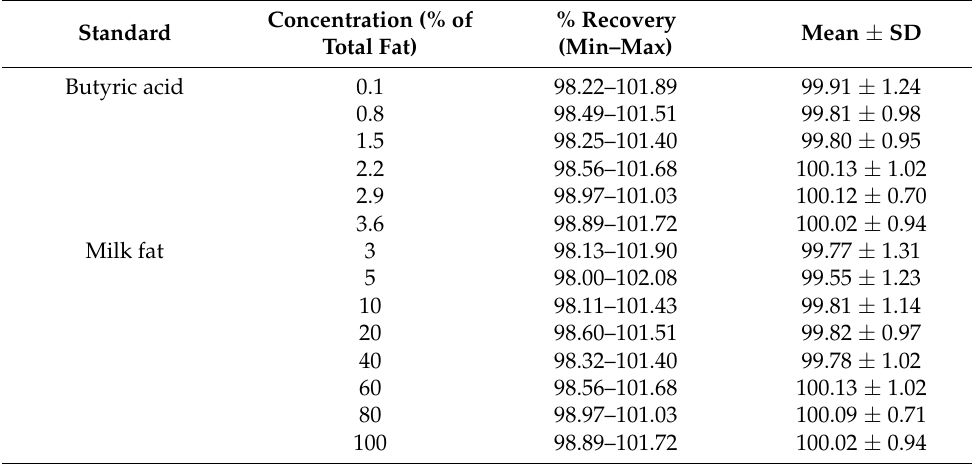
Table 2. Recovery study of butyric acid and milk fat content (n = 10).